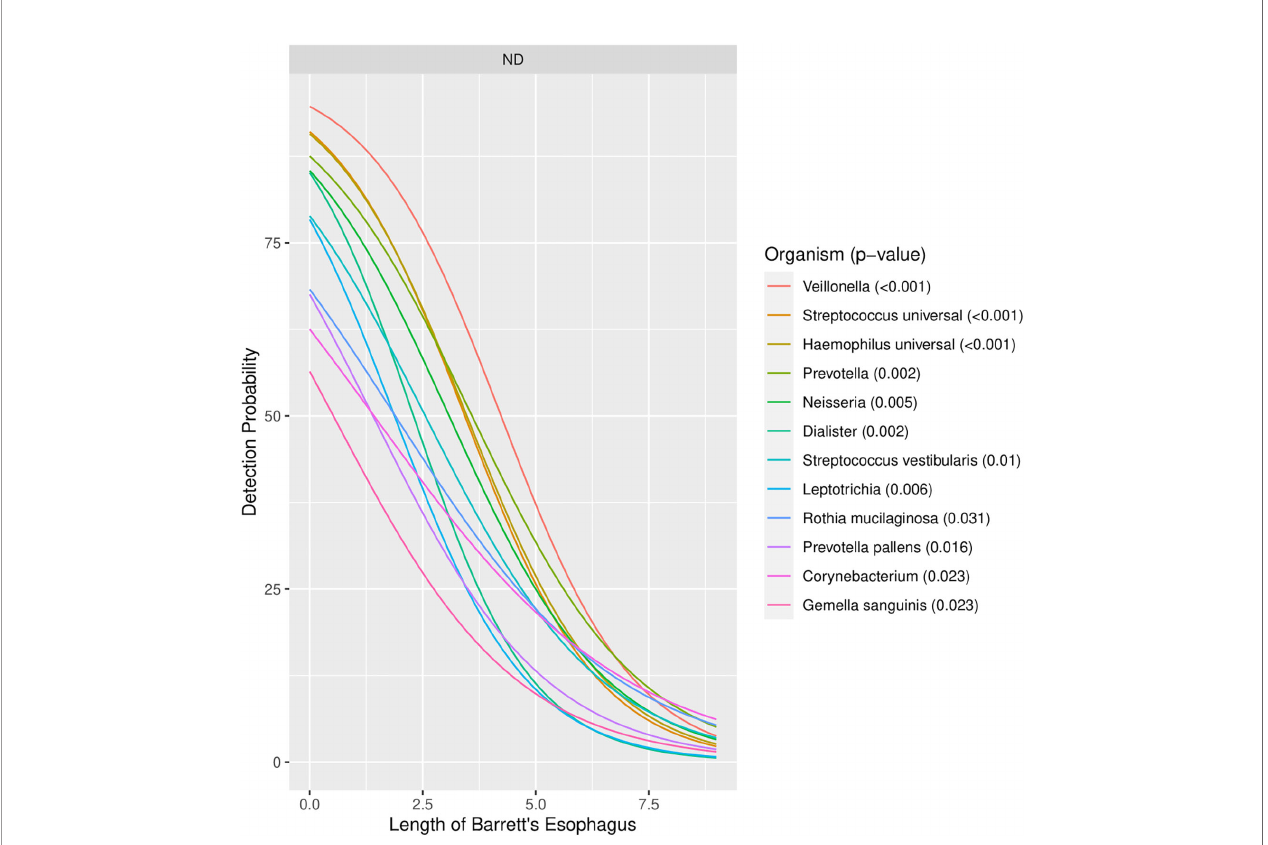
FIGURE 3 | Organisms with detection rates which correlated with length of Barrett ’ s